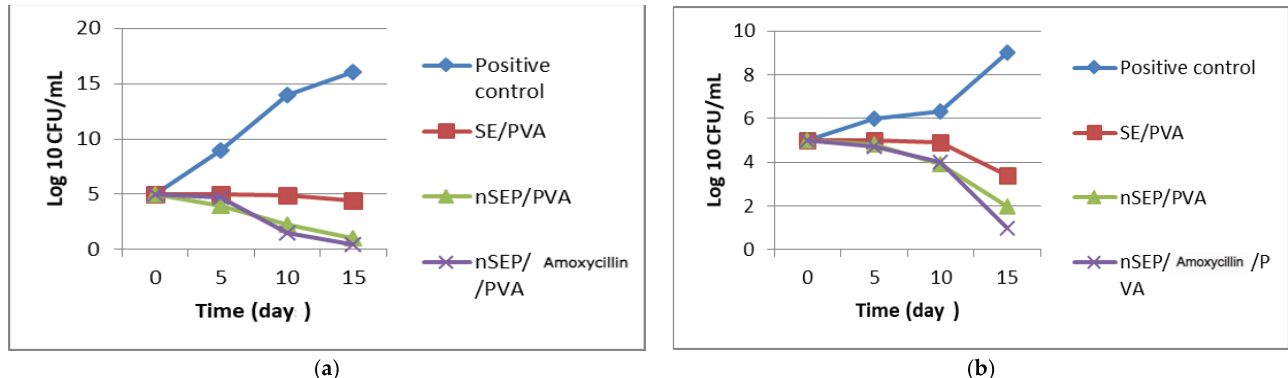
Figure 10. Bacterial load count ( a ): nondiabetic and ( b ): diabetic.